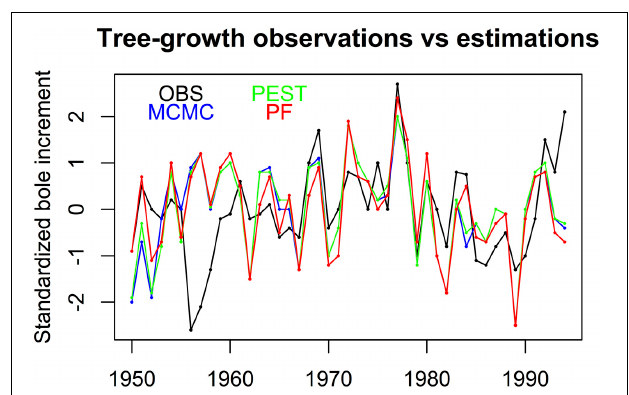
FIGURE 2 | The Pinus halepensis bole biomass increments measured (mean earlywood density multiplied by earlywood width plus mean latewood density multiplied by latewood width) (Rathgeber et al., 2003) and simulated by MAIDEN, using three calibration methods (green PEST, blue MCMC, red PF); All the variables are standardized to be unitless. Adapted from Gaucherel et al.